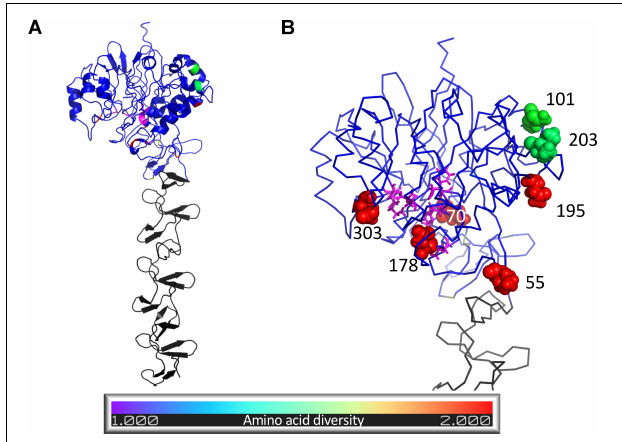
FIGURE 6 | Structural model of Erysipelothrix rhusiopathiae SpaA protein predicted using I-TASSER. Residues structurally aligned to the active site of the S. pneumoniae Pce protein are colored magenta while the remaining residues of the N-terminal domain (residues 1–447) are colored following the legend according to amino acid diversity (Inverse Simpson index) calculated from 343 SpaA sequences sourced from newly sequenced isolates and public sequence databases. Residues of the C-terminal domain (residues 448–626) are colored gray. (A) Cartoon representation of whole structural model showing secondary structure. (B) Close up ribbon representation of N-terminal domain with spheres highlighting the nine residues with highest amino acid diversity (Inverse Simpson index > 1.3) and with residues structurally aligned to the active site of the S. pneumoniae Pce protein (magenta) shown in stick format. Figure created using Pymol